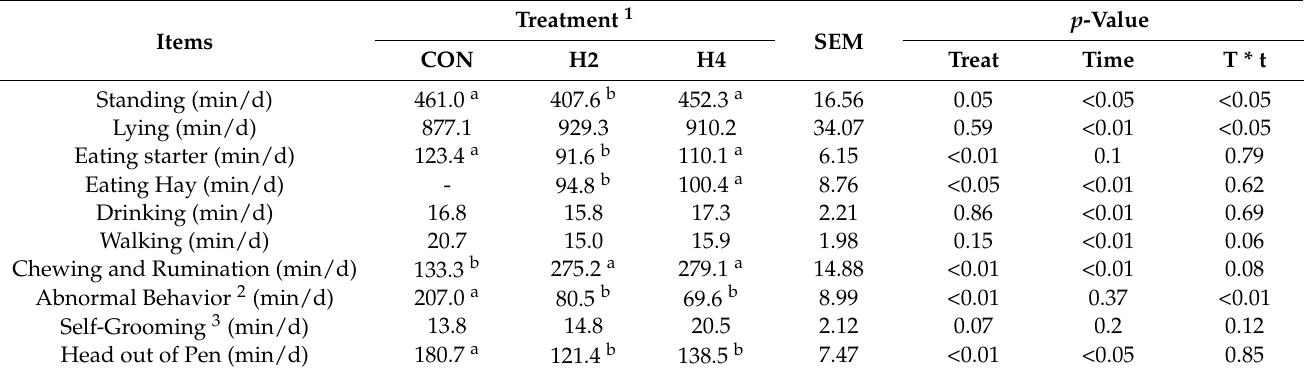
Table 8. Effects of hay supplementation at different ages on behavior in dairy calves (CON: n = 14; H2: n = 14; H4: n =